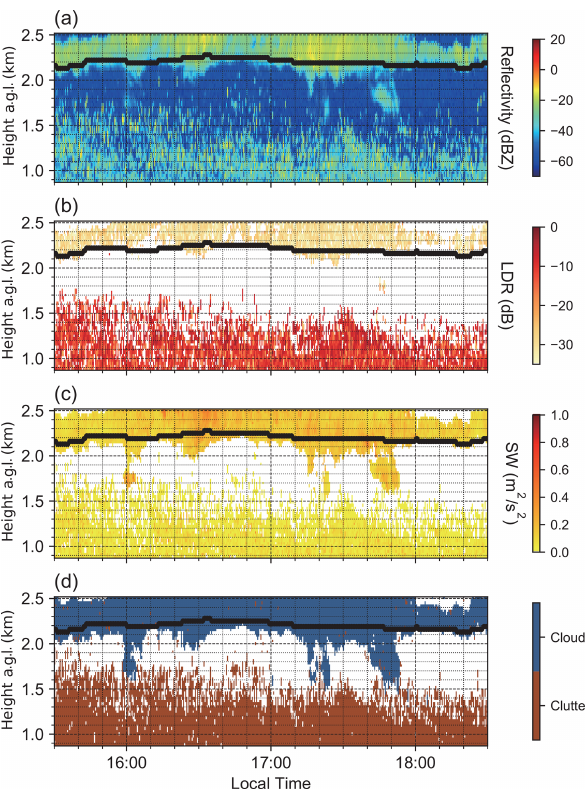
Figure 10. Same as Fig. 8 but from 15:30 to 18:30LT on 7 July 2014.